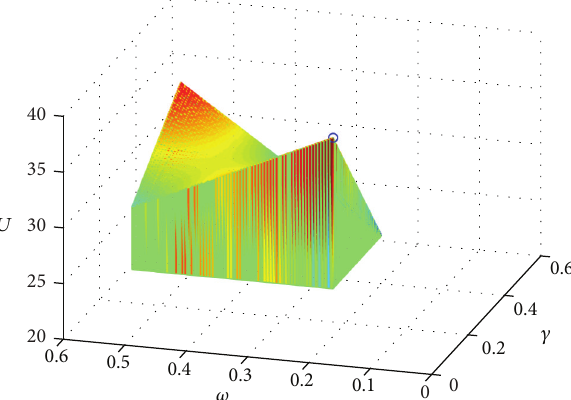
Figure 3: Different circumstances assignment system-wide maxi- mum weighted revenue